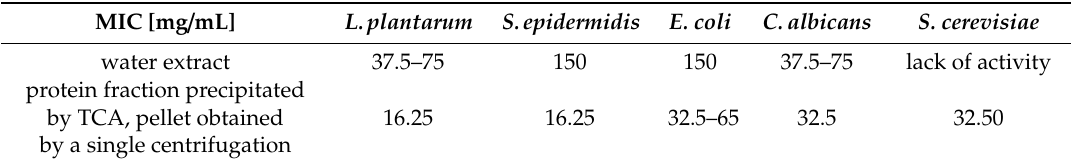
Table 2. Minimal inhibitory concentration (MIC) of the aqueous extract of Chlorella sp. biomass and the protein fraction against various